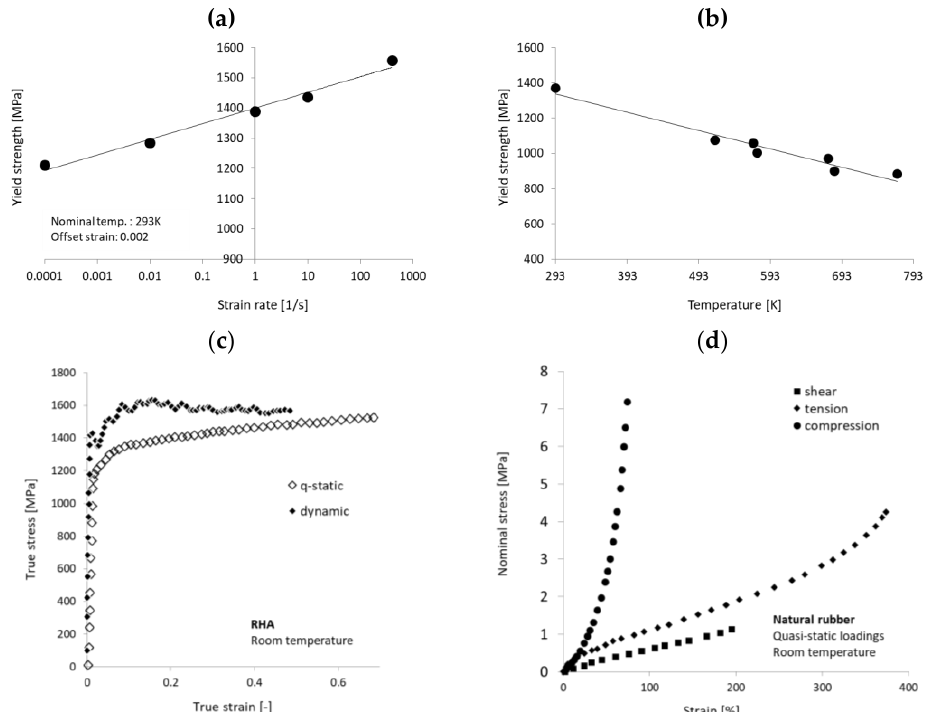
Figure 2. Tungsten heavy alloy of the grade Y925: ( a ) strain rate and ( b ) temperature sensitivity]. ( c ) Quasi-static and dynamic flow curves of an RHA steel, ( d ) quasi-static curves of natural rubber. Graphes based on the data collected in